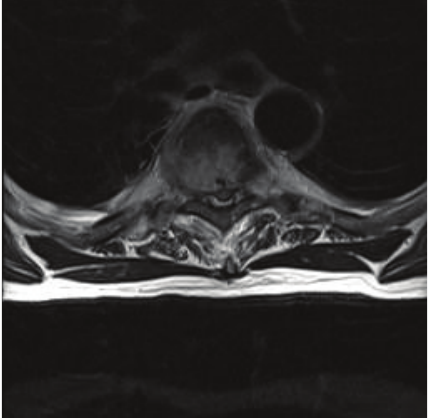
Figure 2: MRI scan, sagittal T2 weighted image, showing posterior soft tissue mass at the level of T5 with associated pathological fracture and diffuse paravertebral oedema. There is evidence of moderate compression of the spinal cord.